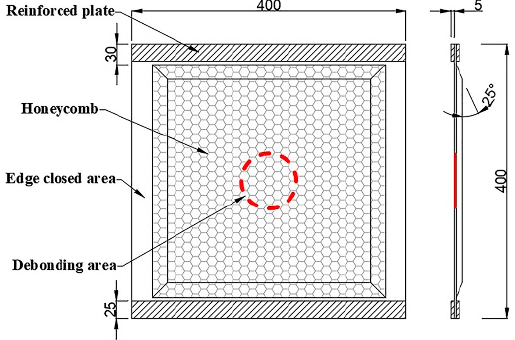
Figure 1. The configuration of specimens.